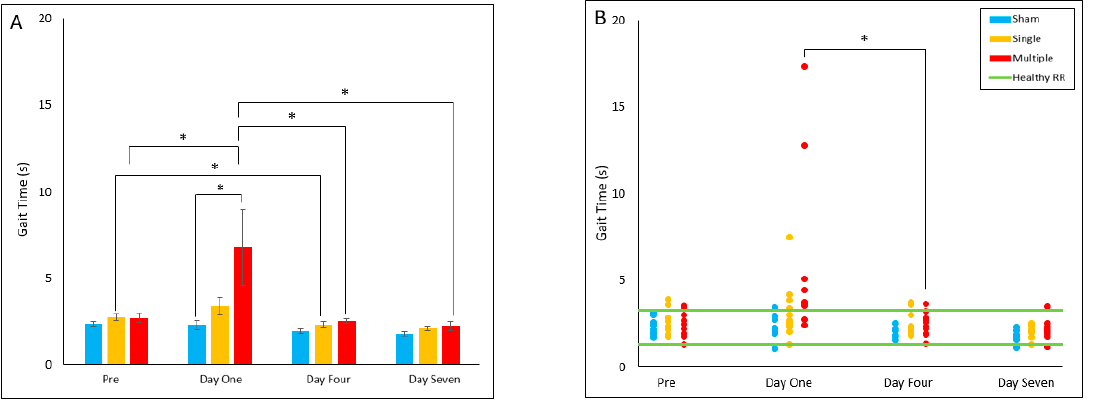
Figure 1. Number of Stances ( A ) Presents daily group average ± standard error and statistical comparisons noted from the two-way ANOVA with repeated measures analysis; ( B ) Presents indi- vidual animal daily averages and statistical comparisons are noted from the Fisher Exact Test and McNemar’s analysis (* p < 0.05, ** p < 0.01, **** p < 0.001).